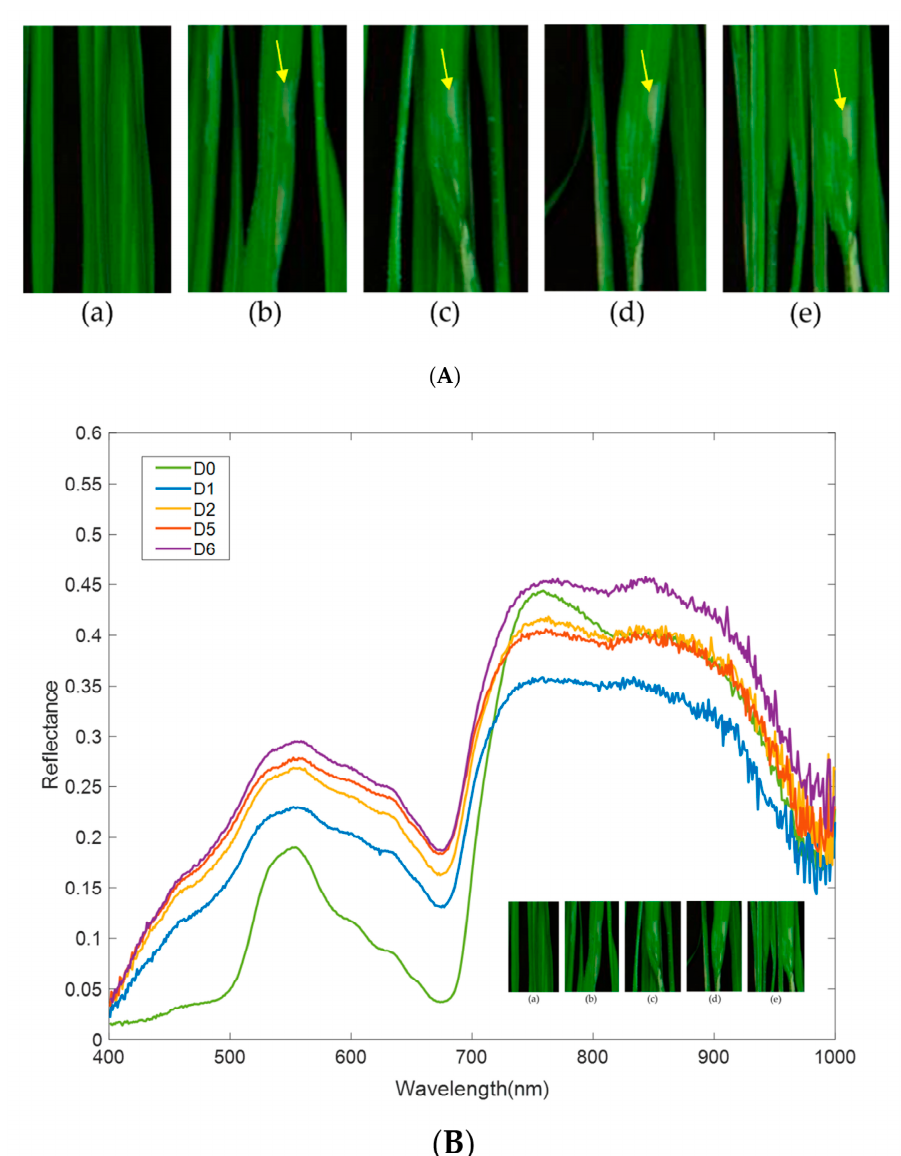
Figure 7. ( A ) Hyperspectral images of healthy leaves on day 0 ( a ) and ocher patches (yellow arrow) infested by rice leaf folders on day 1 ( b ), day 2 ( c ), day 5 ( d ), and day 6 ( e ). ( B ) Spectral signature and corresponding hyperspectral images of the healthy leaves (D0) and ocher patches (from D1 to D6) caused by